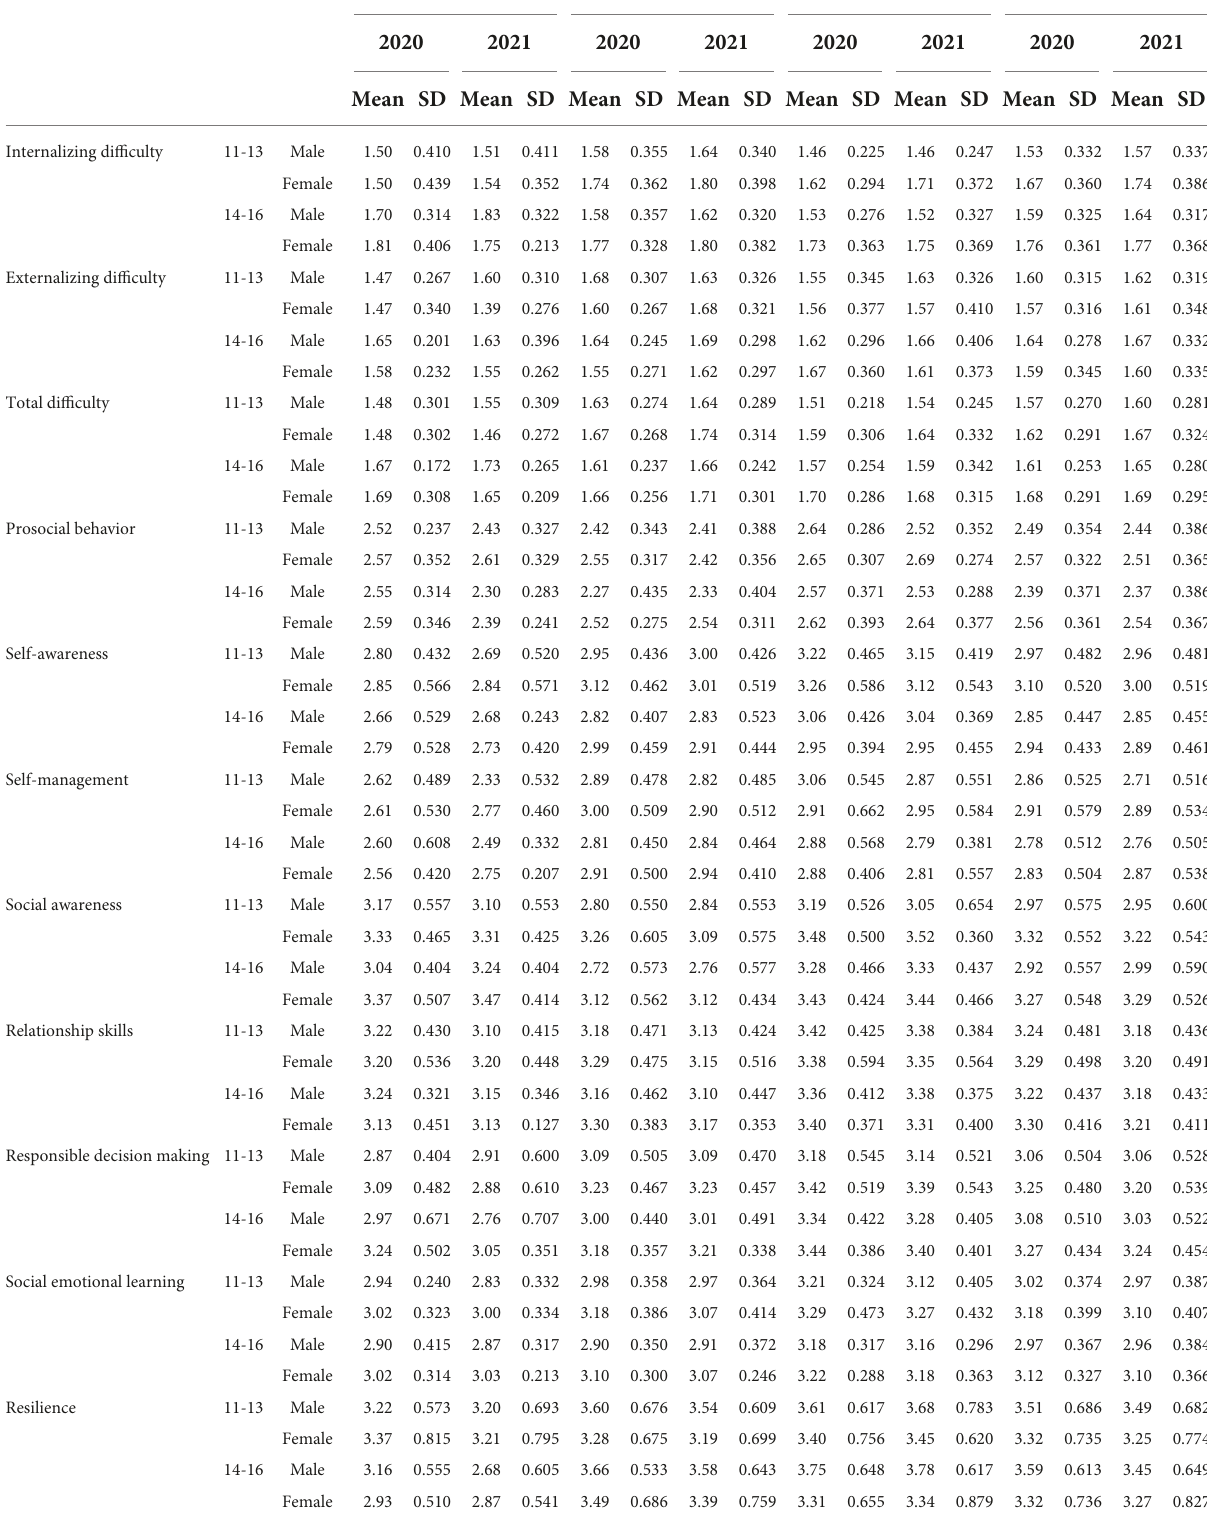
TABLE 5 Mean SDQ, SSIS-SEL, and CD-RISC-10 scores as reported by adolescents ( n = 512). Subscale Age